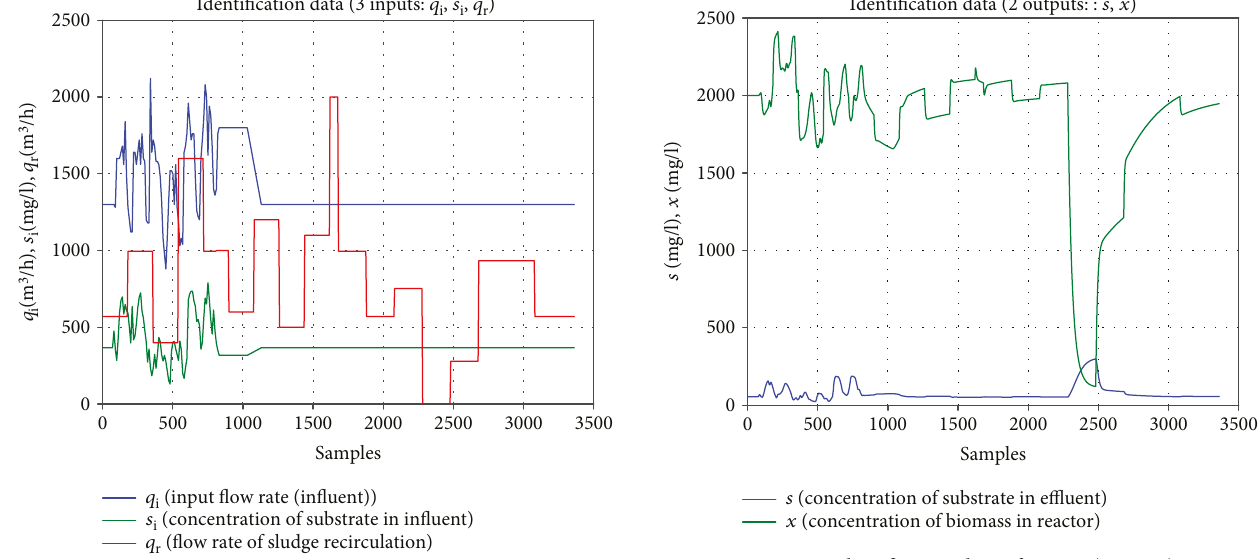
Figure 5: Identi fi cation data of case A (outputs).